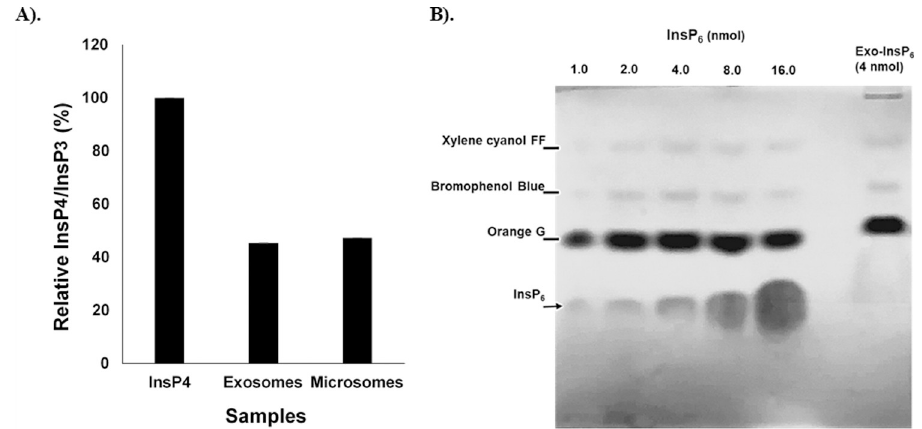
Fig 10. Enzymatic analysis of exosome-based Minpp1 isoform-2. A). Competitive inhibition enzyme immunoassay against exosomes pre-enriched by ultra-centrifugation. The ELISA plate was pre-coated with goat anti-rabbit antibody. Samples were subjected to the plate along with antibodies specific to InsP 3 and Horseradish Peroxidase (HRP)- conjugated InsP 3 . The competitive inhibition reaction is launched between HRP labeled InsP 3 and unlabeled InsP 3 with the antibody. On adding HRP substrate solution, color develops reciprocally to the amount of InsP 3 in the sample. Samples were spiked with 5 μ M InsP 4 for 24h RT. Exosomes (~1.0 μ g) were resuspended in Minpp1 assay Buffer with 16mM CHAPS. Microsomes (~1.0 μ g) were resuspended in Minpp1 assay Buffer with 3mM CHAPS. The bar graph shows the percentage of InsP 4 dephosphorylation as a qualitative activity of Minpp1 isoform-2 enzyme compared to control (InsP 4 +Minpp1 Assay Buffer). B). Hydrolysis of InsP 6 (4 nmol) with exosomes as an indication of Minpp1 isoform-2 enzyme activity. Freshly collected serum-free conditioned media was differentially ultra-centrifuged to isolate exosomes. The isolated exosomes were resuspended in Minpp1 enzymatic assay buffer and later incubated overnight with InsP 6 (4 nmol) at room temperature. After incubation, metabolized InsPs were resolved by PAGE and visualized with toluidine blue staining.